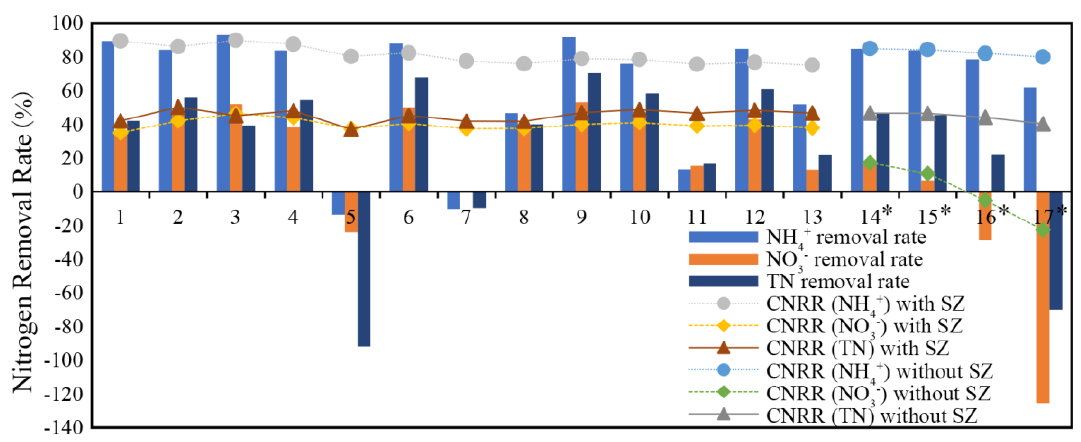
Figure 4. Nitrogen removal rates of NH 4 + , NO 3 − and TN in each event. The first 13 events were simulated in a bioretention system with a 300 mm high SZ and the last 4 events (*) were simulated in the same system without SZ. Note: CNRR = cumulative nitrogen removal rate.